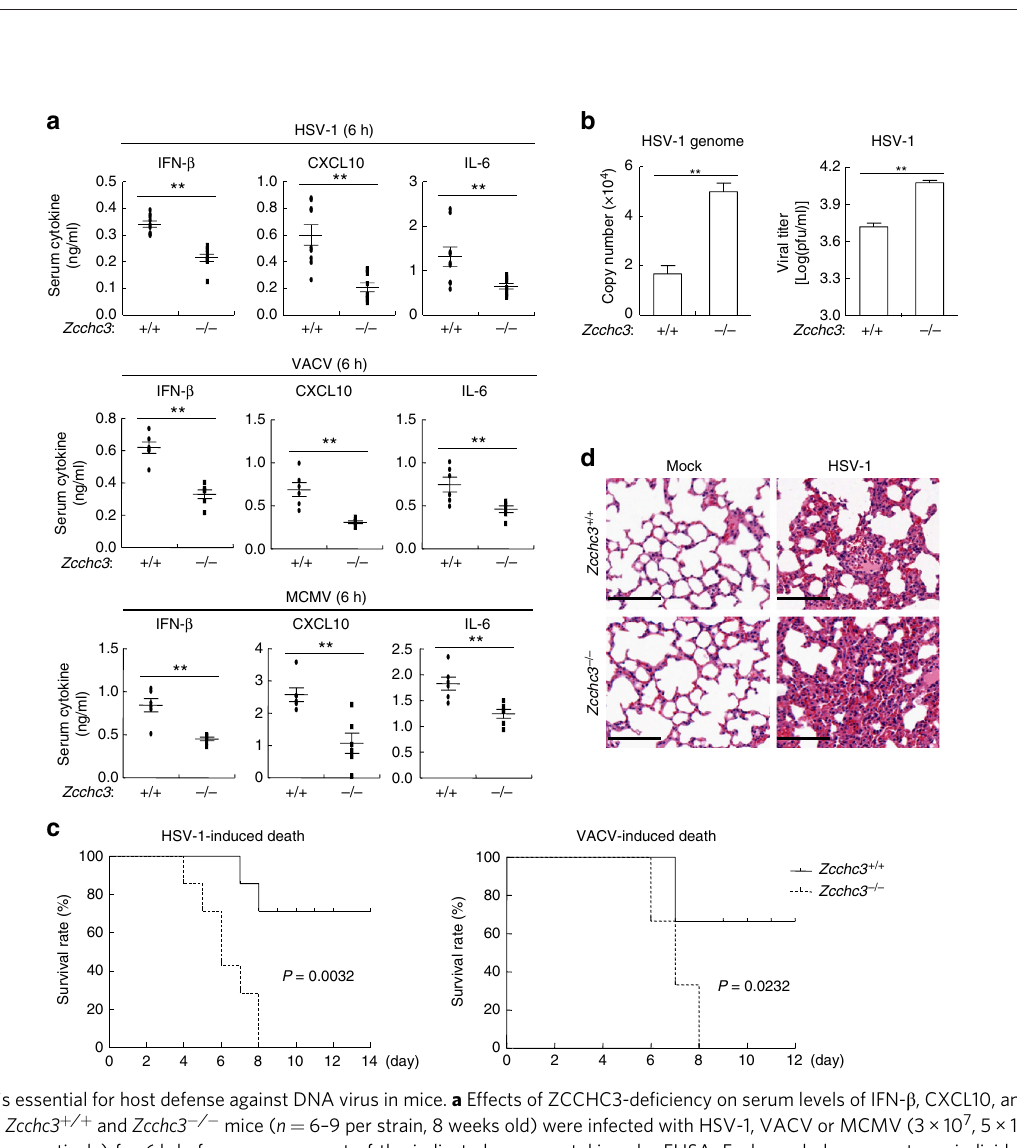
Fig. 2 ZCCHC3 is required for DNA virus- or dsDNA-triggered induction of downstream genes. a Effects of ZCCHC3-de fi ciency on HSV-1- or VACV- induced transcription of downstream genes in BMDMs. Zcchc3 + / + and Zcchc3 − / − BMDMs were left un-infected or infected with HSV-1 or VACV for 6 h before qPCR analysis. b Effects of ZCCHC3-de fi ciency on MCMV- or VACV-induced transcription of downstream genes in MLFs. Zcchc3 + / + and Zcchc3 − / − MLFs were left un-infected or infected with MCMV or VACV for 6 h before qPCR analysis. c Effects of ZCCHC3-de fi ciency on HSV-1-induced transcription of downstream genes in MLFs and MEFs. Zcchc3 + / + and Zcchc3 − / − MLFs or MEFs were left un-infected or infected with HSV-1 for the indicated times before qPCR analysis. d Effects of ZCCHC3-de fi ciency on transcription of downstream genes induced by transfected dsDNAs. Zcchc3 + / + and Zcchc3 − / − MLFs or MEFs were transfected with the indicated dsDNAs for 4 h before qPCR analysis. e Effects of ZCCHC3-de fi ciency on transcription of Ifnb1 gene induced by different doses of HSV120. Zcchc3 + / + and Zcchc3 − / − MLFs were transfected with increased amounts of HSV120 for 4 h before qPCR analysis. The percentage reduction transfection of Ifnb1 in Zcchc3 − / − compared with Zcchc3 + / + MLFs was shown in the right panels. f Effects of ZCCHC3-de fi ciency on HSV-1-induced phosphorylation of TBK1, IRF3, and ΙκΒα . Zcchc3 + / + and Zcchc3 − / − BMDMs were left un-infected or infected with HSV-1 for the indicated times before immunoblotting analysis. * P < 0.05, ** P < 0.01 (unpaired t test). Data are representative of at least two experiments with similar results (mean ± SD, n = 3 independent samples in a – e )